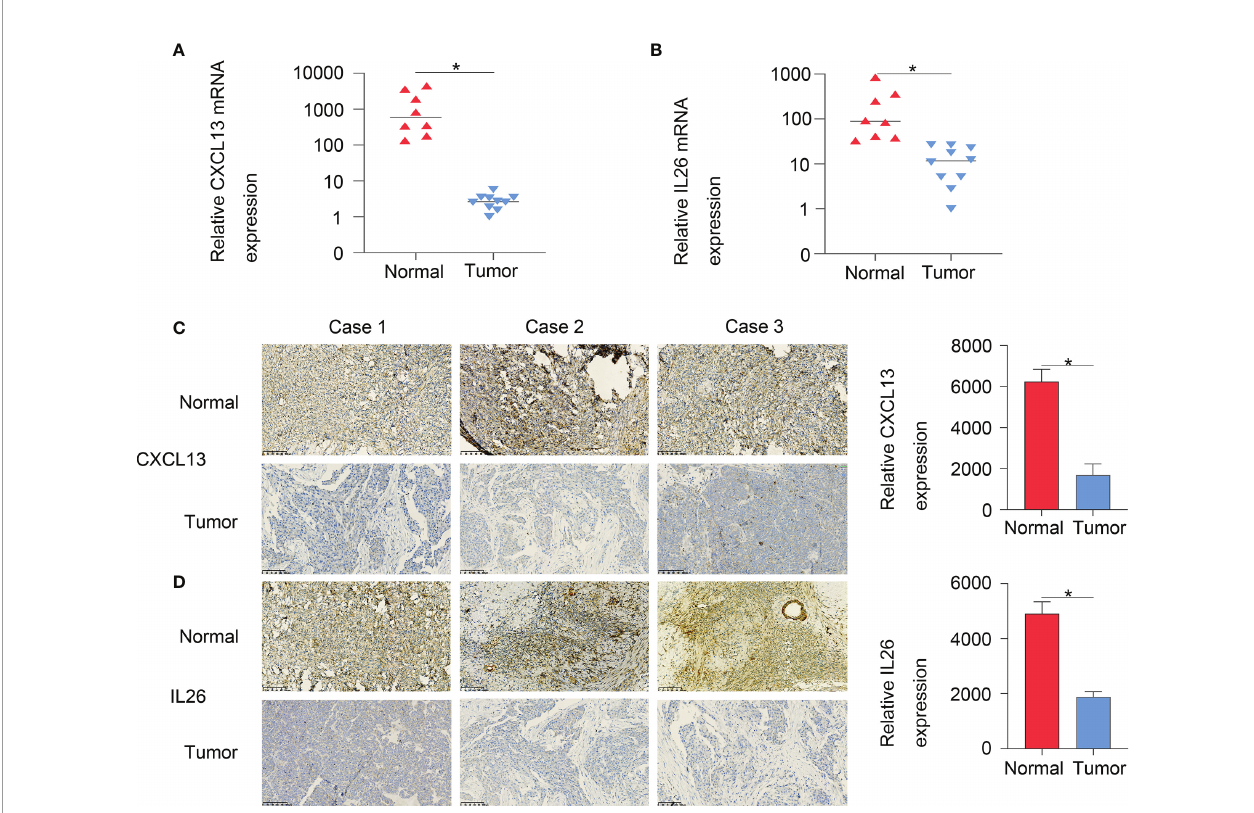
Supplementary Figure S1 | The Kaplan-Meier curves of patients with different proportions of M1-like myeloid cells: (B) disease free interval(DFI) (C) overall